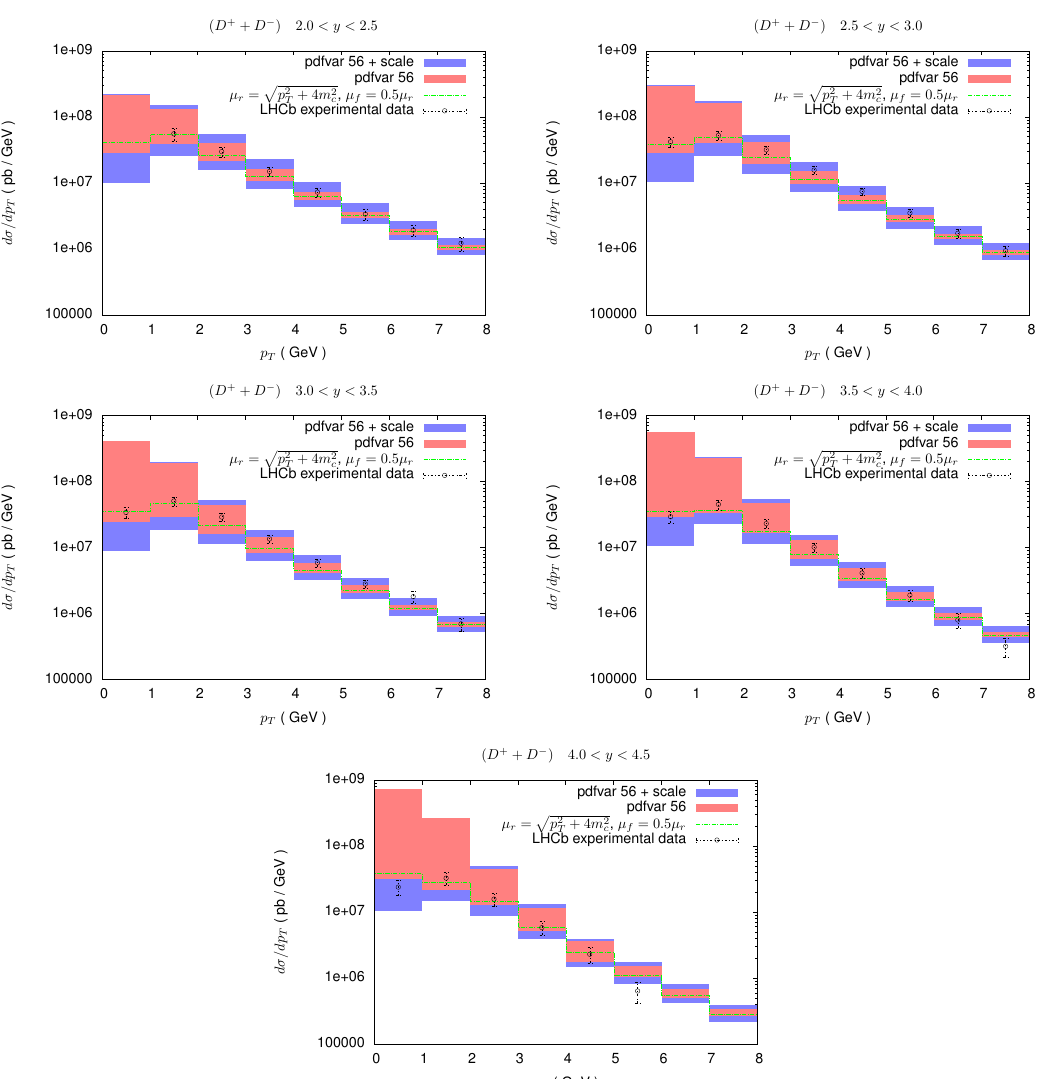
Figure 18 . Our GM-VFNS predictions for ( D + + D (cid:0) ) transverse-momentum distributions in pp collisions at p S = 7 TeV vs. LHCb experimental data of ref. [42]. Each panel corresponds to a di(cid:11)erent rapidity bin in the interval 2 < y < 4.5. The PDF uncertainties and the scale plus PDF uncertainties are computed as in (cid:12)gure